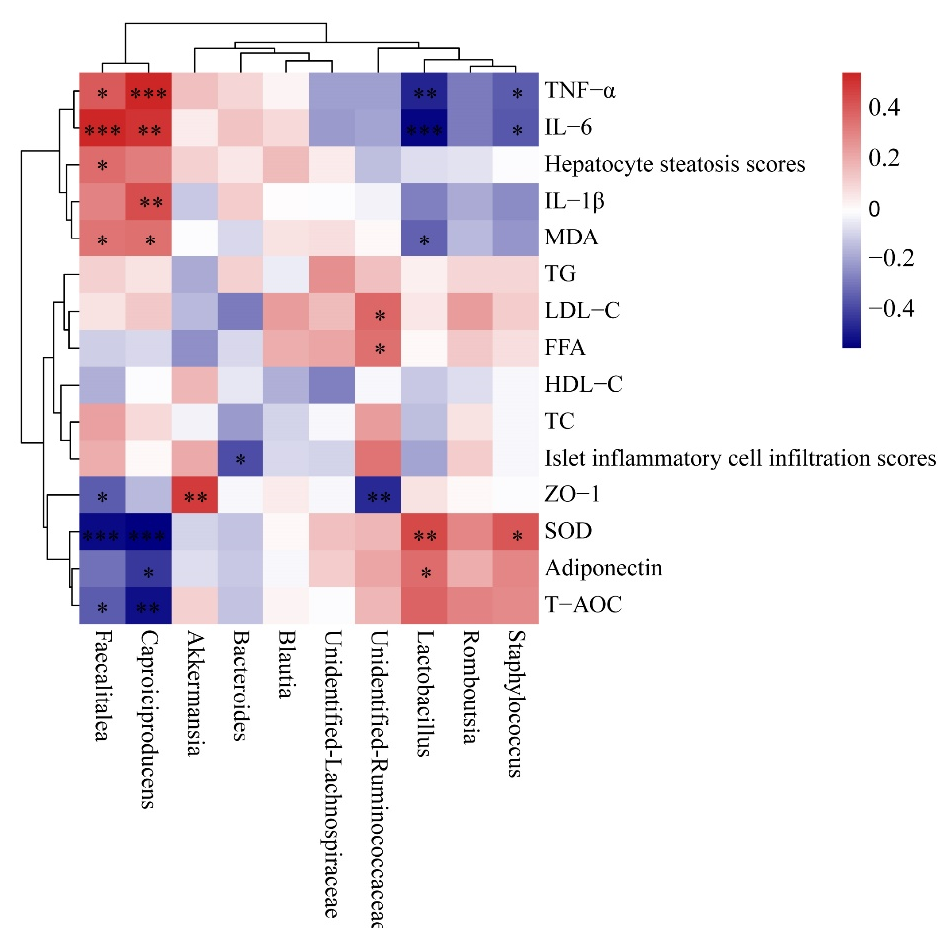
Figure 8. Heatmap of Spearman’s correlation between gut microbiota (top 10 at genus level) and pro-inflammatory cytokine, antioxidant capability, and lipid metabolism-related indices. * p < 0.05, ** p < 0.01, *** p < 0.001. TG, total triglyceride; TC, total cholesterol; HDL-C, high-density lipoprotein